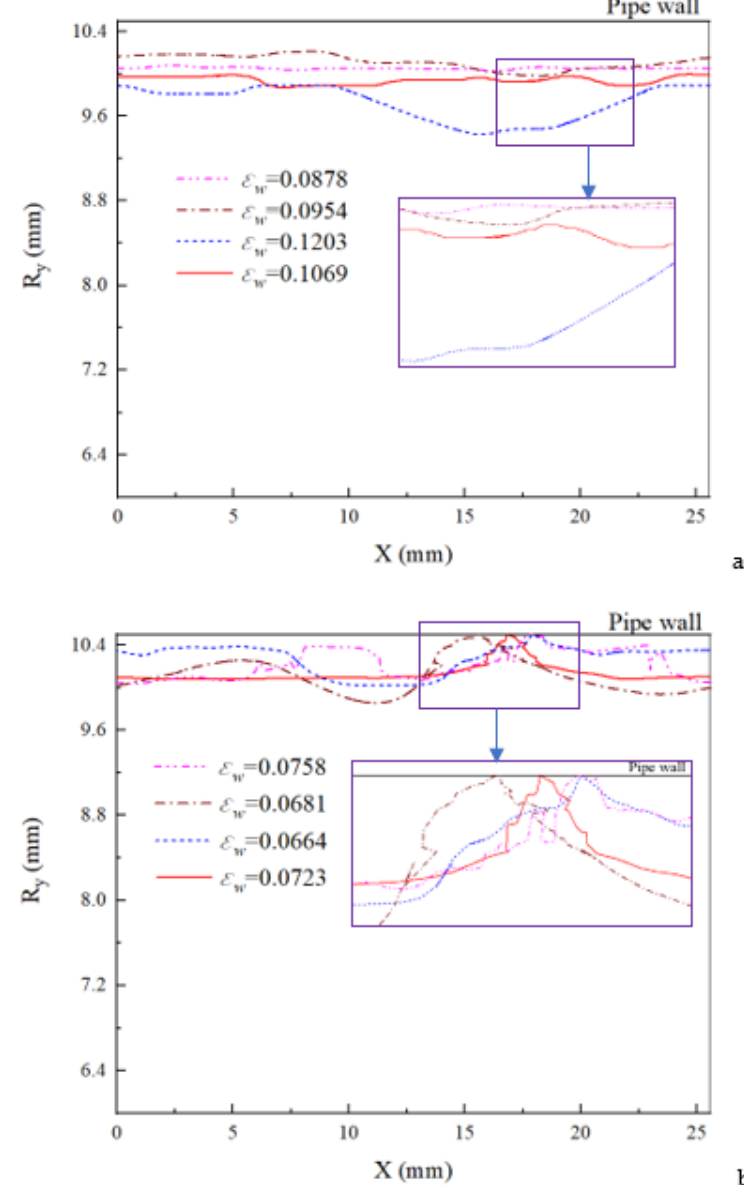
Figure 7. The top interfacial wave on the top of pipe. ( a ) No fouling; ( b )